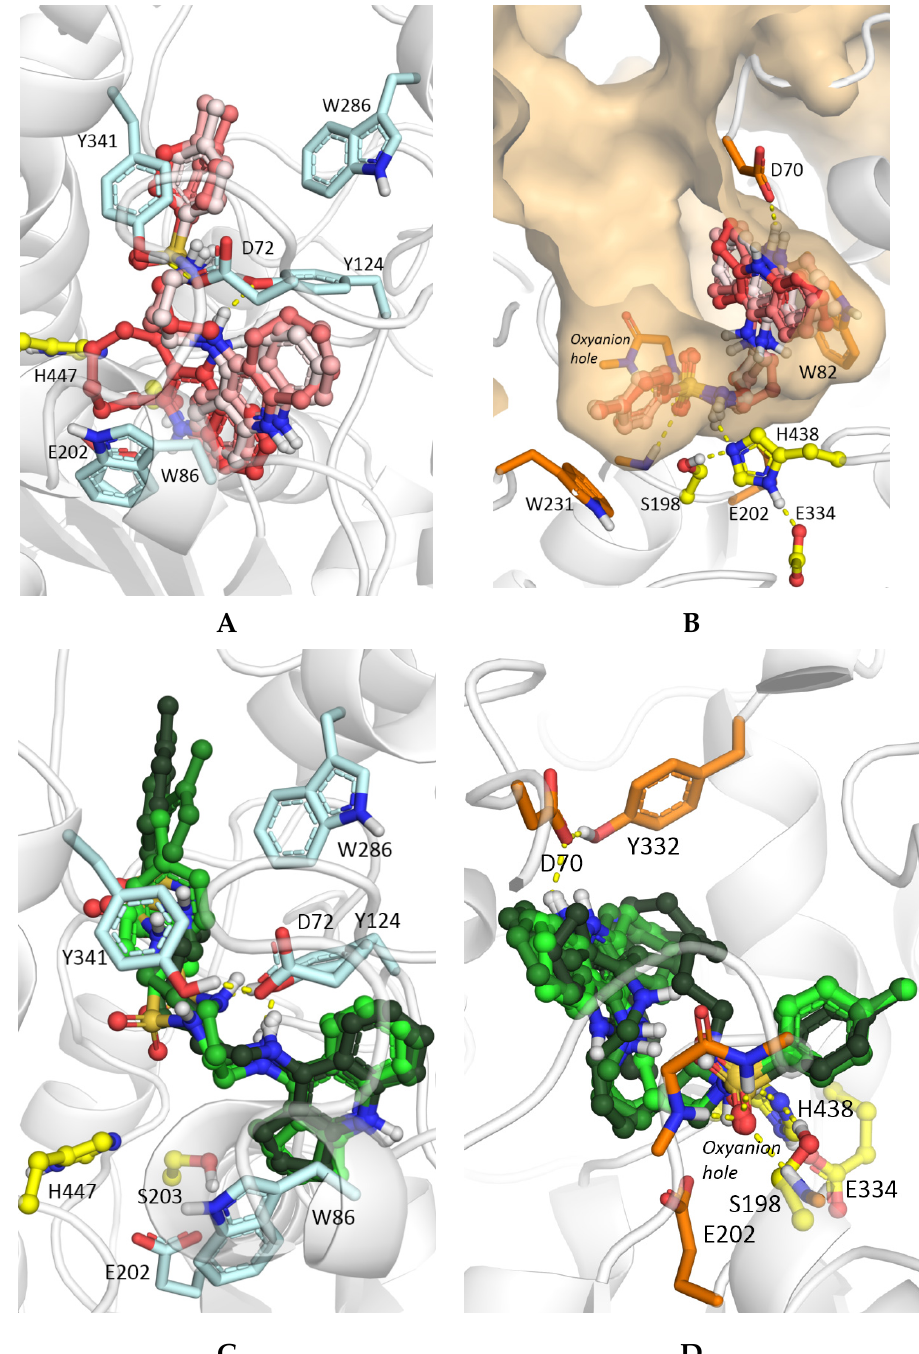
Figure 4. Results of molecular docking of hybrids of 4-amino-2,3-polymethylene-quinoline and p -tolylsulfonamide 7 into AChE (carbon atoms are shown in pale blue) and BChE (carbon atoms are shown in orange). The surface shows the gorge leading from the protein surface to the active site with a hollow space accommodating the aliphatic ring of the tacrine fragment of compounds 7 . Compounds 7b, 7f, 7i, 7k with m = 3 spacers and increasing aliphatic ring size (carbon atoms are shown with different shades of red from pale for 7b (C-5) to bright for 7k (C-8) inside ( A ) AChE and ( B ) BChE. Compounds 7a–7e with C-5 aliphatic rings and increasing spacer length (carbon atoms are shown with different shades of green from pale for 7a ( m = 2) to dark for 7e ( m = 6) inside ( C ) AChE and ( D ) BChE.